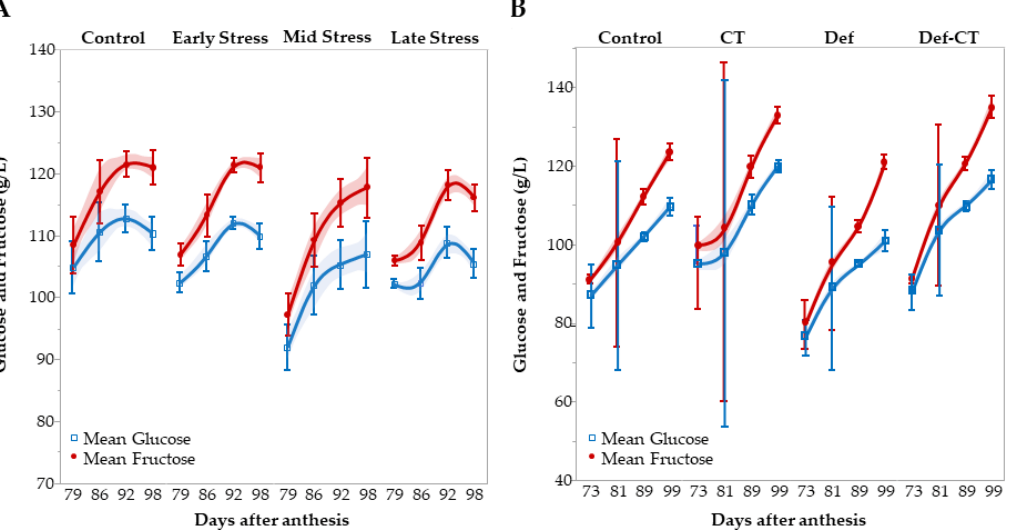
Figure 2. Development during ripening in glucose and fructose in water stress ( A ) and field ( B ) trials. Keys: ‘Control’ = no treatment; ’CT’ = crop-thinning; ‘Def’ = defoliation; ‘Def-CT’ = defoliation and crop-thinning. Vertical bars show the 95% confidence intervals. Shaded areas indicate 95% confidence of fit (spline function).